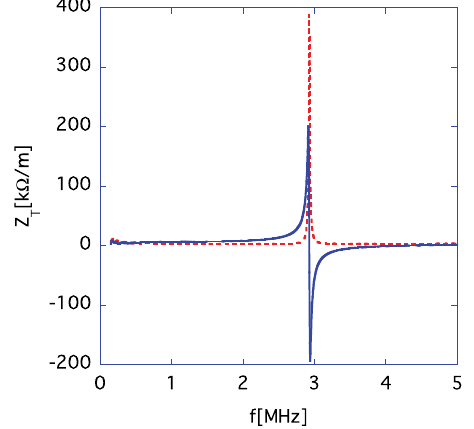
FIG. 5. A schematic illustration of the modified kicker in terms of electric circuit theory [7,8]. The location “ A ” shows the current monitoring point of Fig.